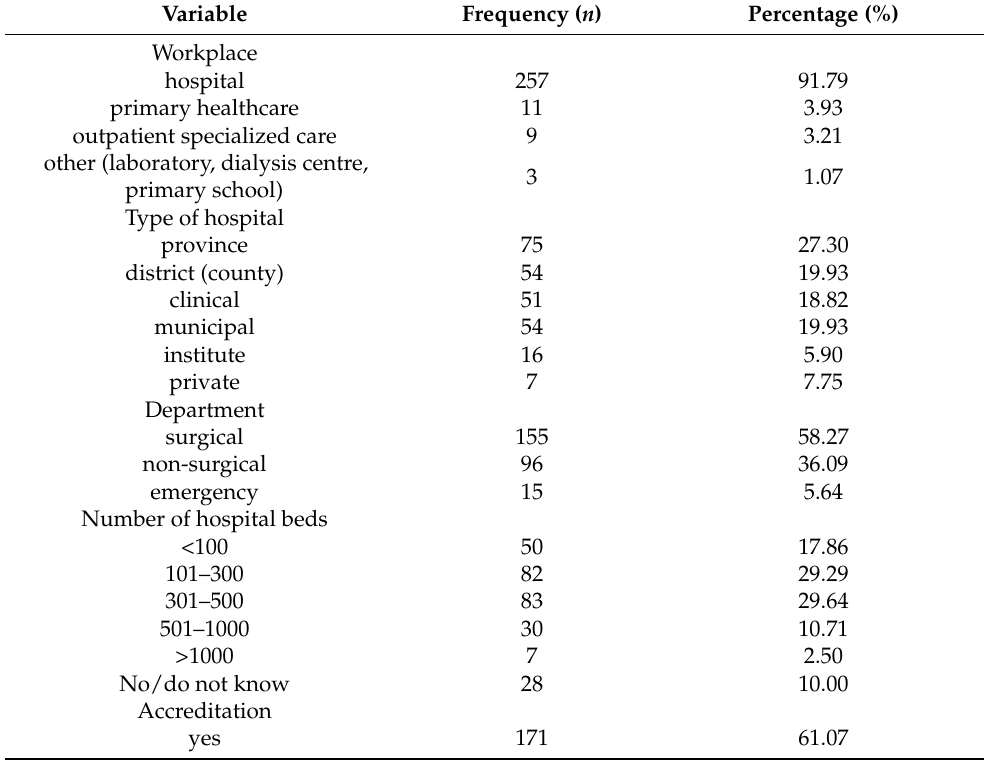
Table 2. Characteristics of the workplace of the